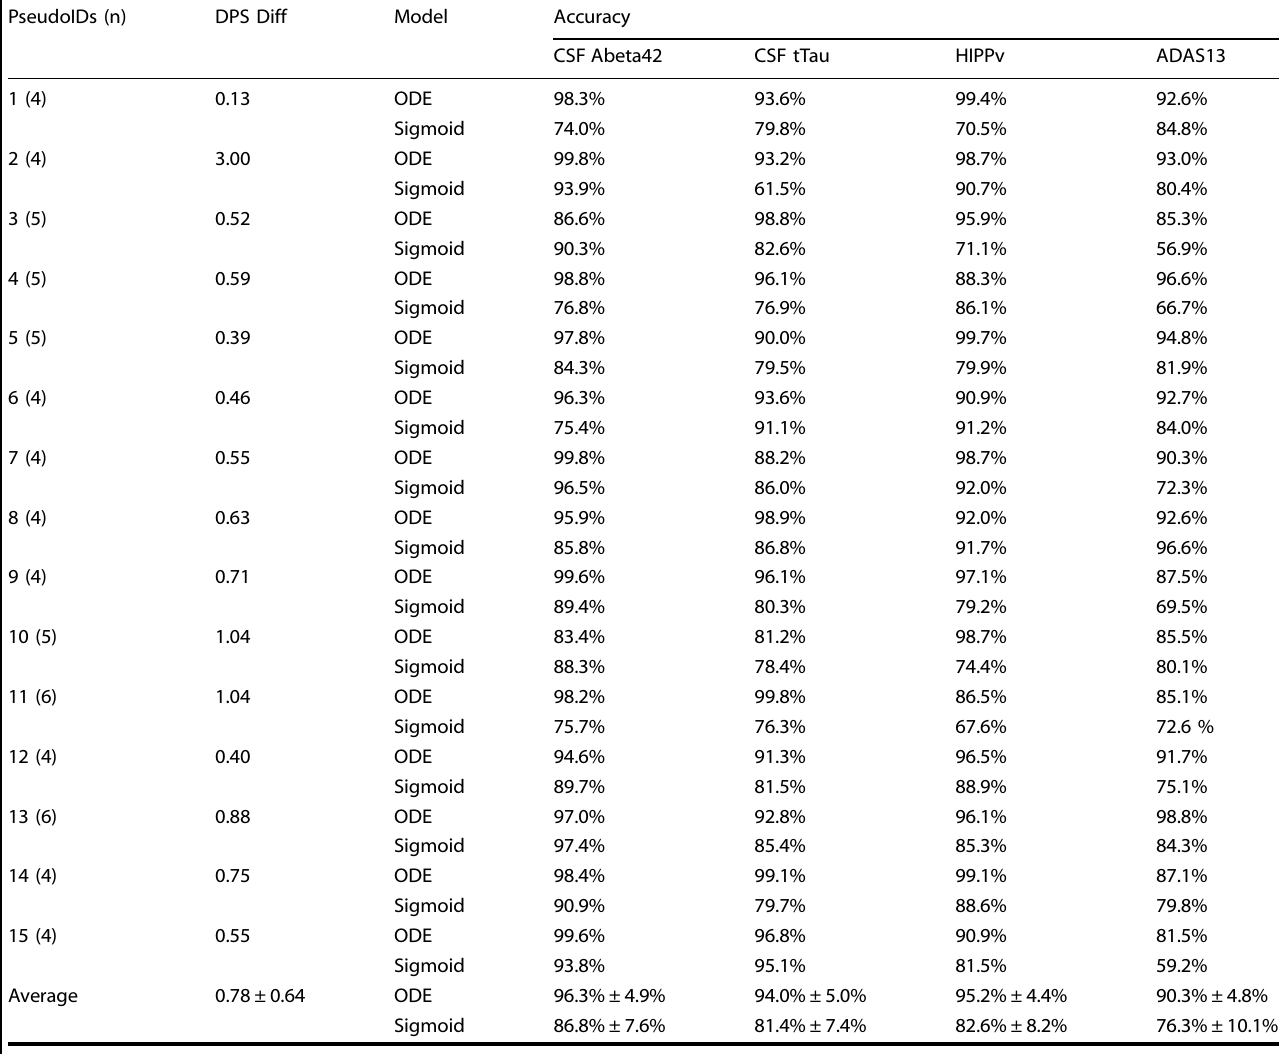
Table 2. The prediction accuracy summary for CN subjects using different numbers of longitudinal biomarker datapoints ( n ). PseudoIDs